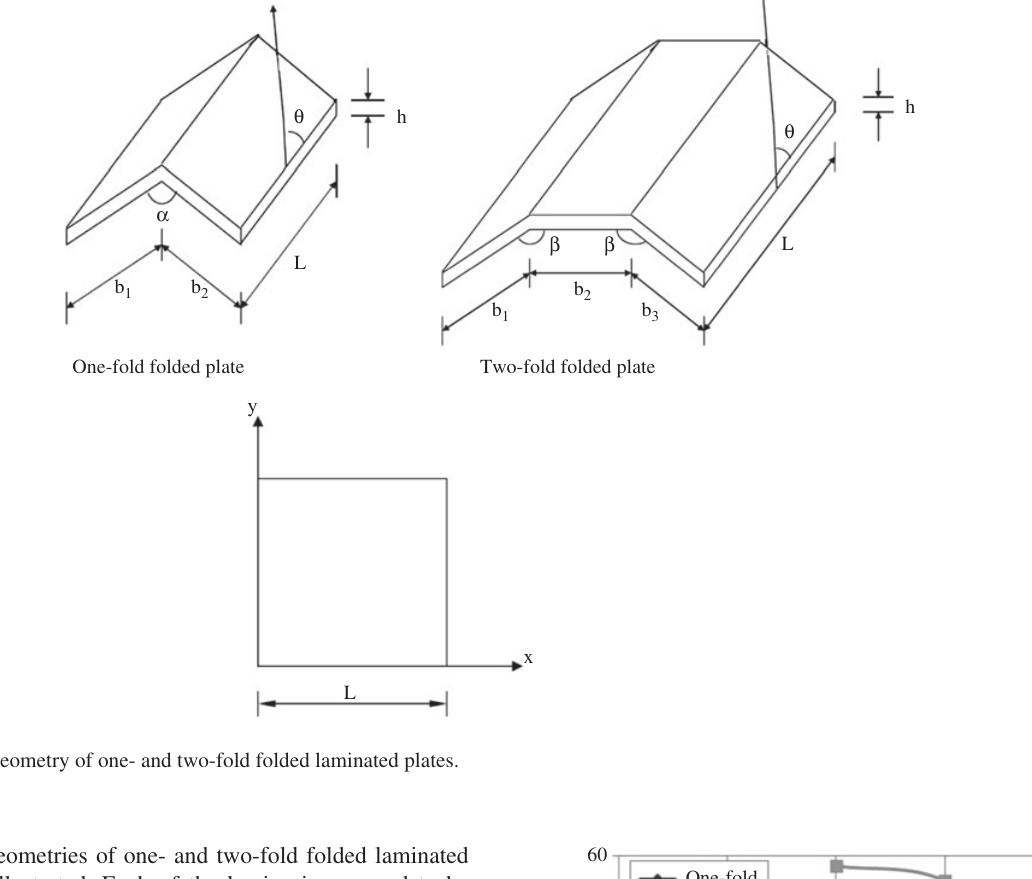
Figure 2 , geometries of one- and two-fold folded laminated plates are illustrated. Each of the lamina is assumed to be